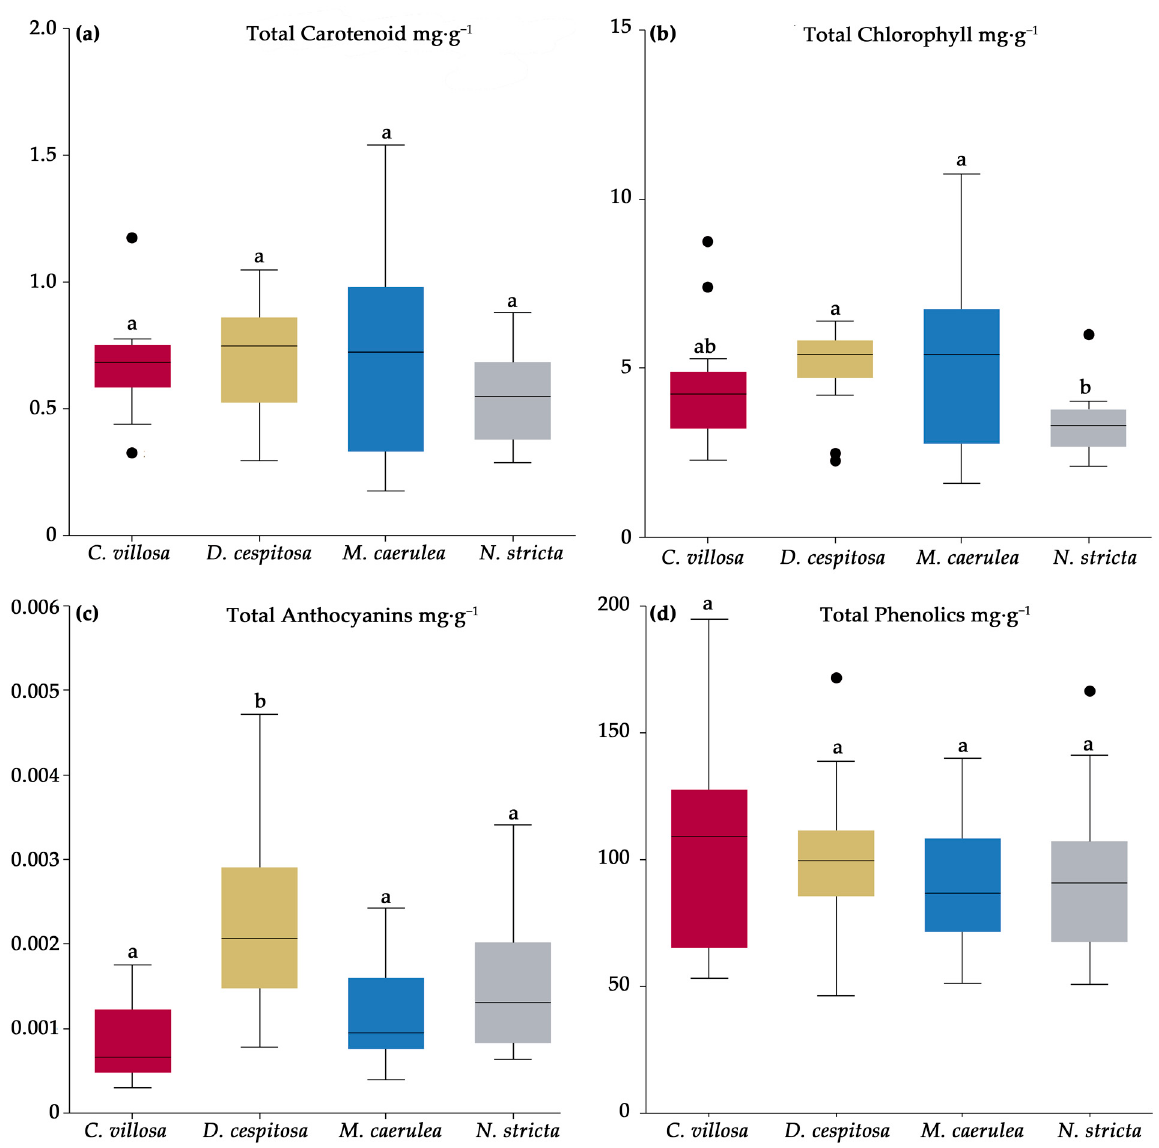
Figure 5. Total pigments of carotenoids ( a ), chlorophylls ( b ), anthocyanins ( c ), and phenolics ( d ) for Calamagrostis villosa (red boxes), Deschampsia cespitosa (yellow boxes), Molinia caerulea (blue boxes), and Nardus stricta (grey boxes), measured in 2020 and averaged over the growing season; n = 18 per species. Medians (central line); 25 and 75 percentiles (boxes); 1.5 interquartile range (error bars); and outliers (dots) are indicated. Different letters denote significance, α = 0.05 (One-way ANOVA and Tukey–Kramer post-hoc test).